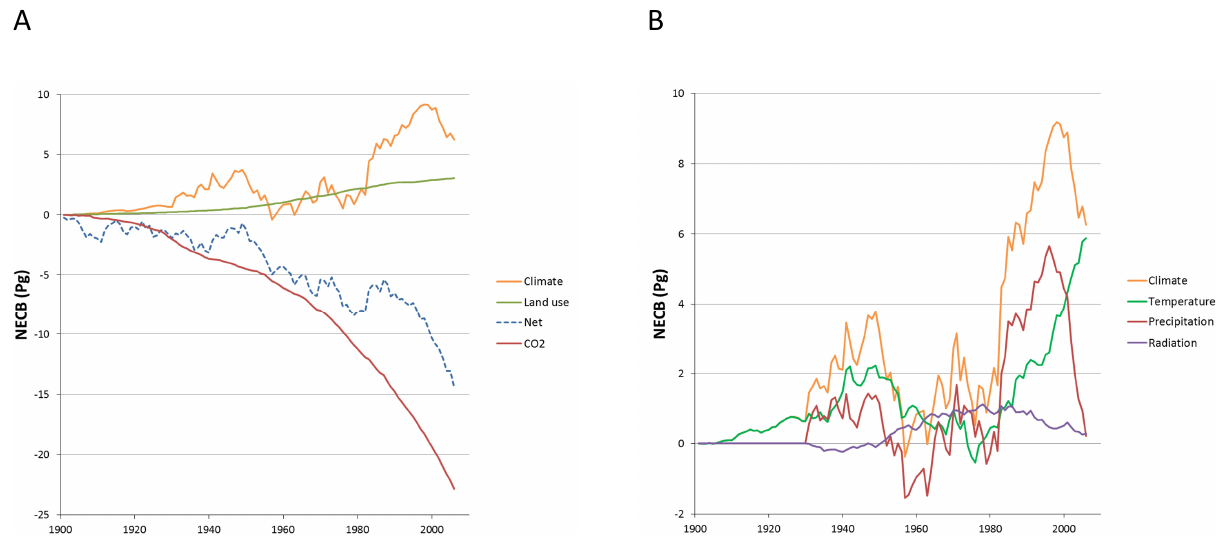
Fig. 11. (A) Separate contributions of CO 2 , climate and land use change to the modelled 1901–2006 cumulative net ecosystem carbon balance (NECB) for the African continent, derived by comparing a simulation (S1, “Net”) forced by historical CO 2 , climate and land use with separate simulations where one of these components was kept at the spin-up levels throughout the simulation period (see Table 3). For example, the climate component (“Climate”) was derived by subtracting the cumulative NECB of a simulation that considered only CO 2 and land use change from the “Net” simulation that considered CO 2 , land use and climate change. (B) Separate contributions of changing temperature, precipitation and radiation to the modelled 1901–2006 cumulative African NECB, derived by comparing the “Net” simulation above with separate simulations where one climate component was kept at the spin-up levels throughout the simulation period as in (A) . “Climate” is the net climate component as in (A) . Positive values represent a flux to the